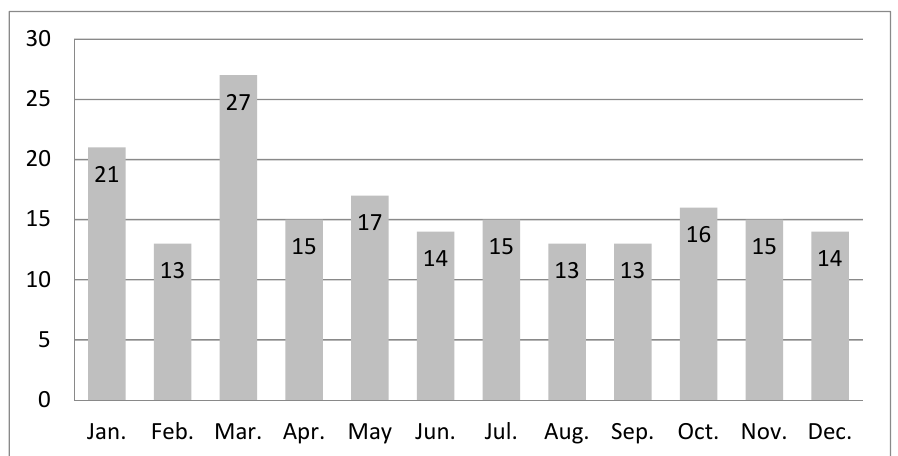
Figure 3. Cumulative numbers of hypoplastic left heart syndrome cases formed in consecutive months in years 2006–2019 ( n = 193, data from our single unit). Overrepresentation of frequency of hypoplastic left heart syndrome formation in March: 27 (14.00%) in comparison to a monthly median of 15. Table 1. Cumulative numbers and percentages of hypoplastic left heart syndrome and single ventricle cases in consecutive months in years 2006–2019.